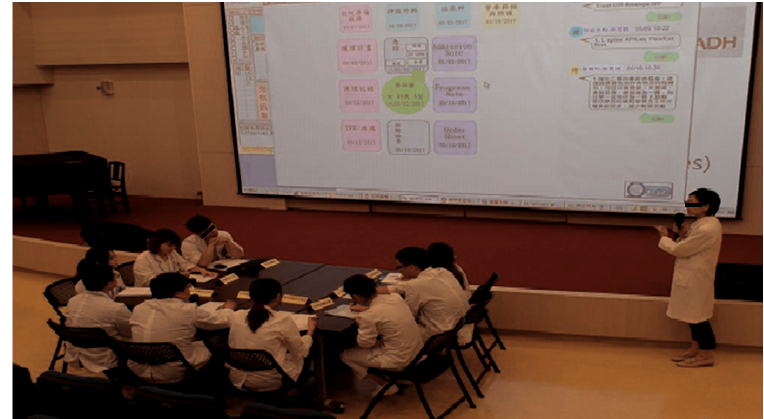
Figure 7. The platform being used during case discussion.